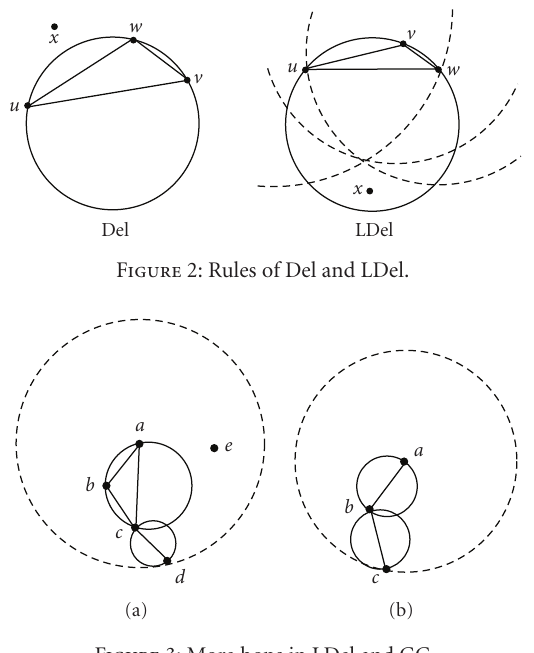
Figure 3: More hops in LDel and